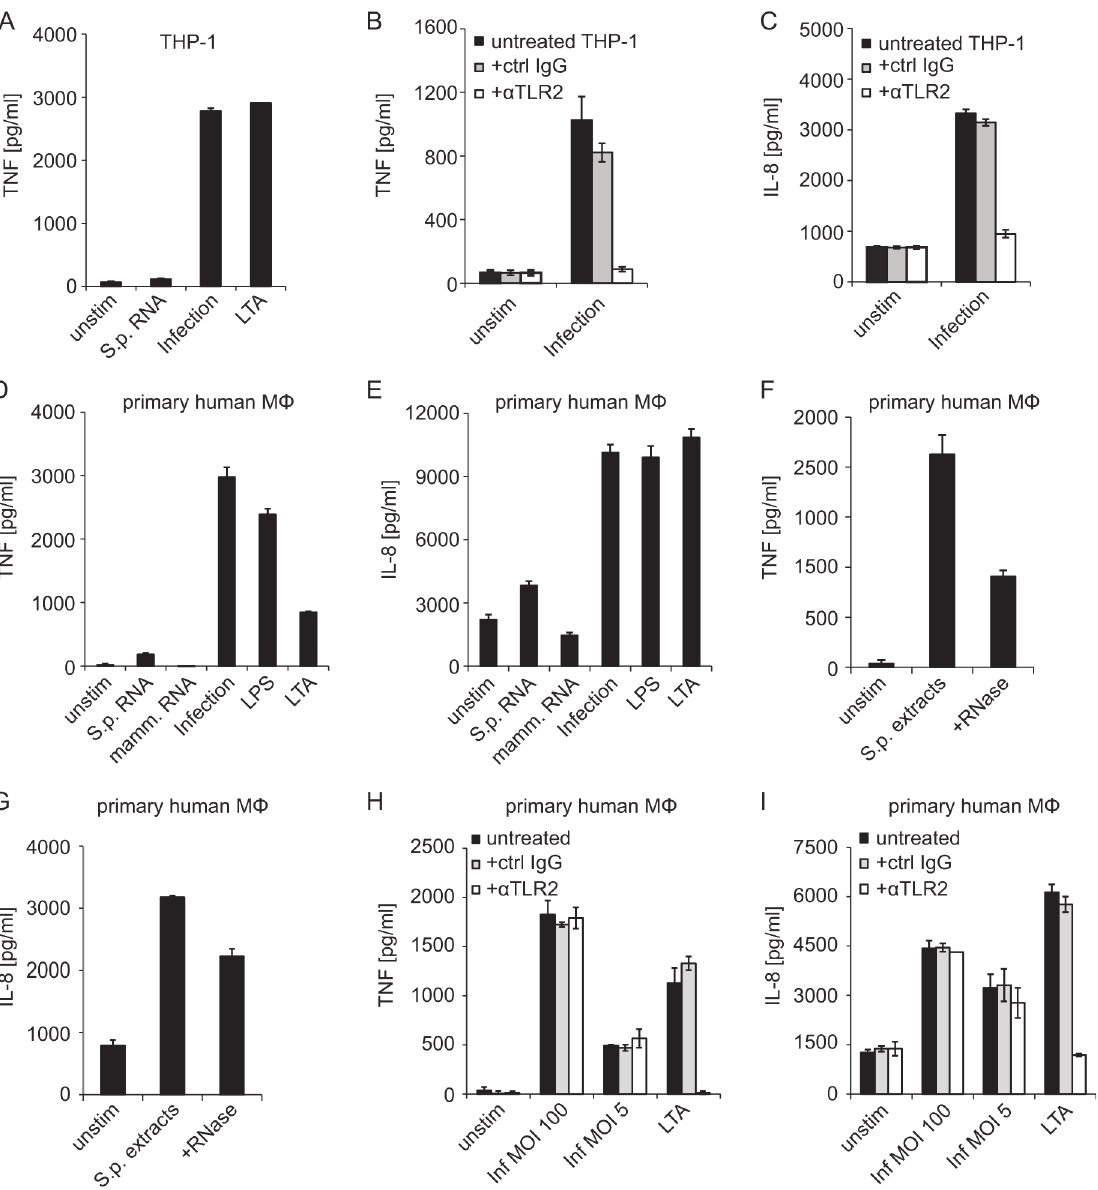
Fig 6. Human macrophage-like cells respond to S . pyogenes infection by TLR2-dependent signaling but fail to recognize S . pyogenes RNA. (A) PMA-differentiated THP-1 macrophages were stimulated with S . pyogenes RNA (5 μ g, using DOTAP), LTA (5 μ g/ml), infected with S . pyogenes (MOI = 100) or left untreated. Supernatants were collected 6 h after treatment and TNF release was measured by ELSA. (B, C) PMA-differentiated THP-1 were incubated with an anti-TLR2 ( α TLR2) or control IgG antibody for 30 min or left untreated prior to infection with S . pyogenes (MOI = 100), supernatants were collected 6 h post infection and TNF (B) or IL-8 (C) release was measured by ELISA. (D, E) Primary human macrophages were either transfected with 5 μ g S . pyogenes or mammalian RNA using DOTAP, infected with S . pyogenes (MOI = 100), stimulated with LTA (5 μ g/ml) or LPS (10 ng/ml) or left untreated. Supernatants were collected after 24 h and TNF (D) or IL-8 (E) release was measured by using ELSA. (F, G) Primary human macrophages were stimulated with S . pyogenes extracts, S . pyogenes extracts treated with RNase (+RNase), or left unstimulated. Supernatants were collected after 6 h and TNF (F) or IL-8 (G) release was measured by ELSA. (H, I) Primary human macrophages were incubated with an anti-TLR2 ( α TLR2) or control IgG antibody for 30 min or left untreated prior to infection with S . pyogenes (MOI = 100 and MOI = 5) or stimulation with LTS. Supernatants were collected 6 h post infection and TNF (H) or IL-8 (I) release was measured by ELISA. Error bars in all panels represent SDs (n (cid:3)